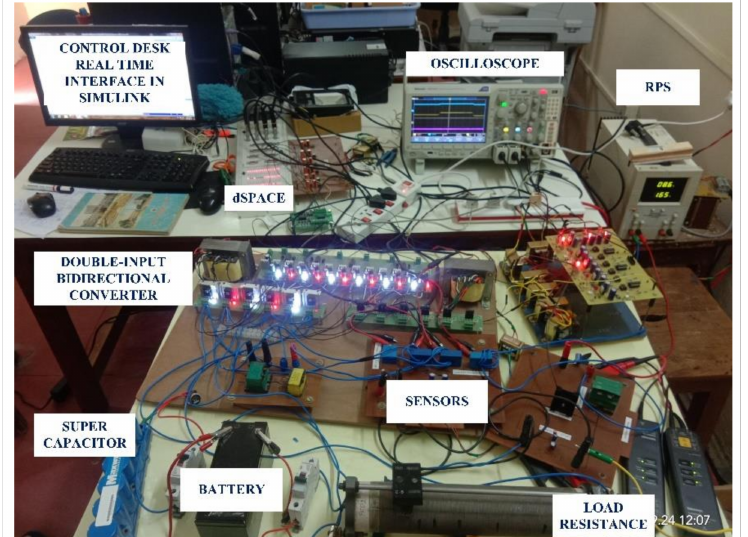
Figure 18. Hardware prototype developed for HESS.